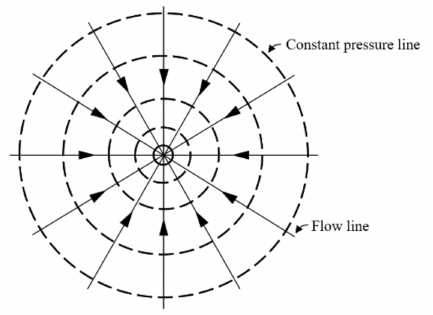
Figure 1. Radial flow